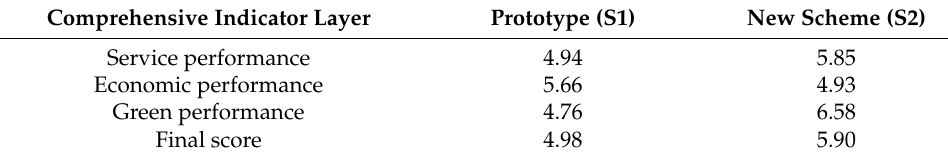
Table 14. Final score